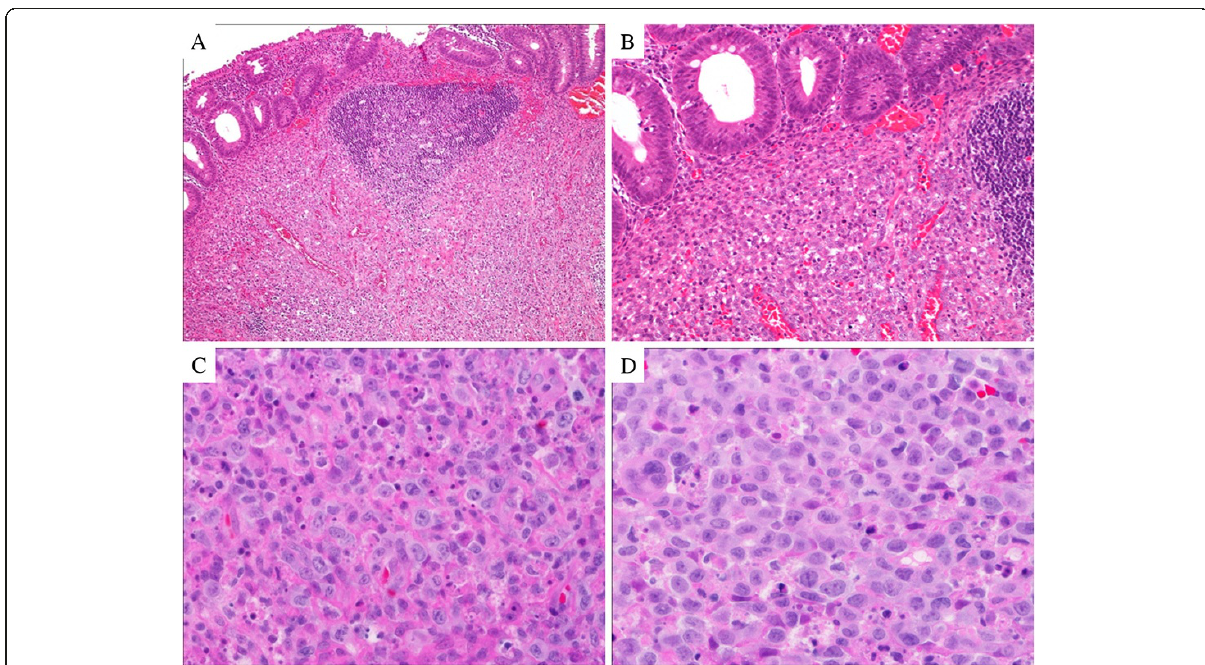
Figure 1 Histological features of the appendix. (A) Atypical lymphoid cells and preserved lymph follicle are in submucosal layer (H&E stain, ×100). ( B) Intraepithelial lymphocytes are not increased, and abnormal tumour cell invasion is not prominent in the mucosal layer (H&E stain, ×200). Large atypical lymphocytes with small distinct nuclei diffusely infiltrate the ( C ) submucosal layer and ( D ) eroded lesion. Many reactive histiocytes are seen, mainly in ( C ) (H&E stain, ×400).